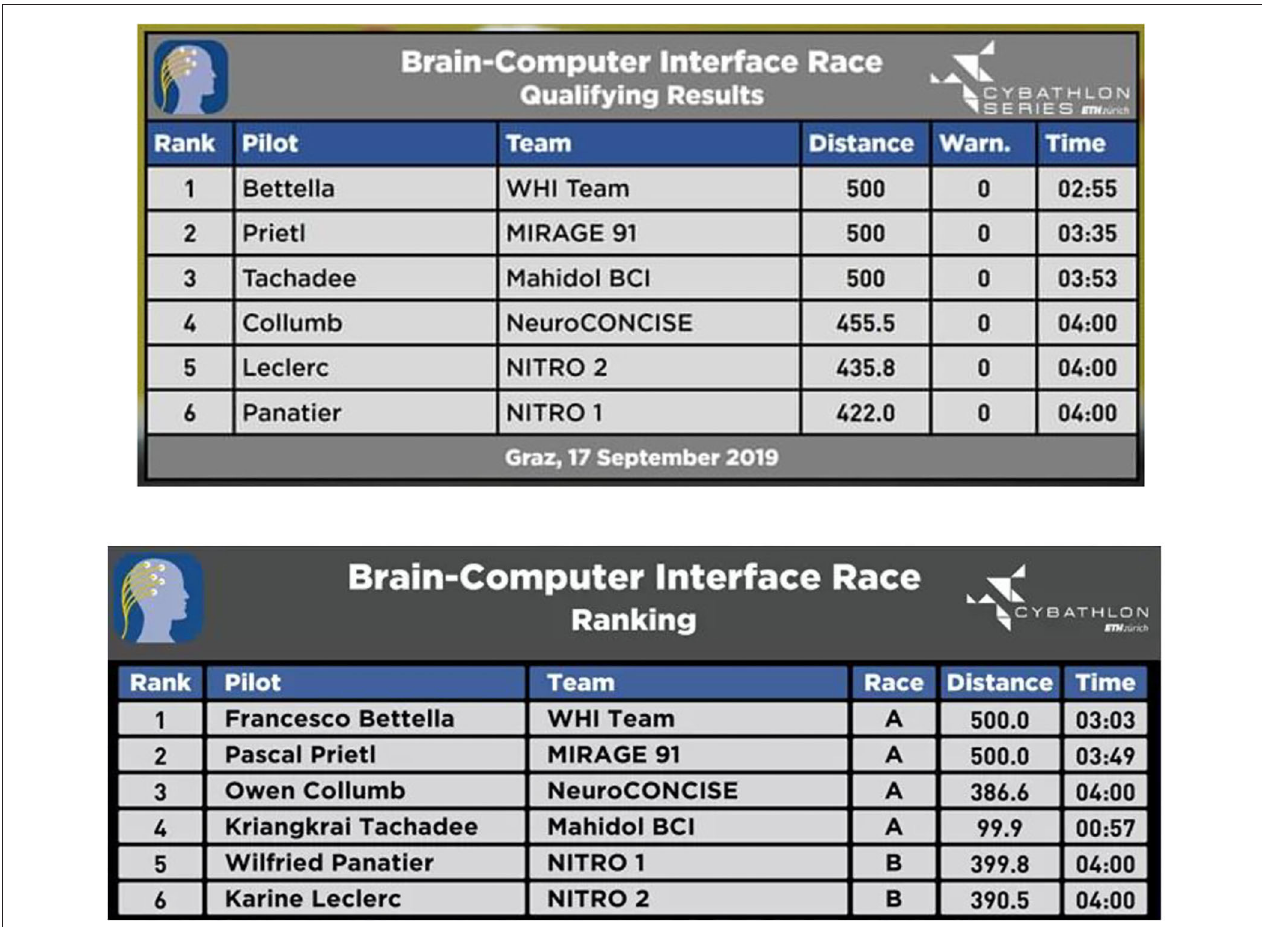
FIGURE 9 | Cybathlon BCI series